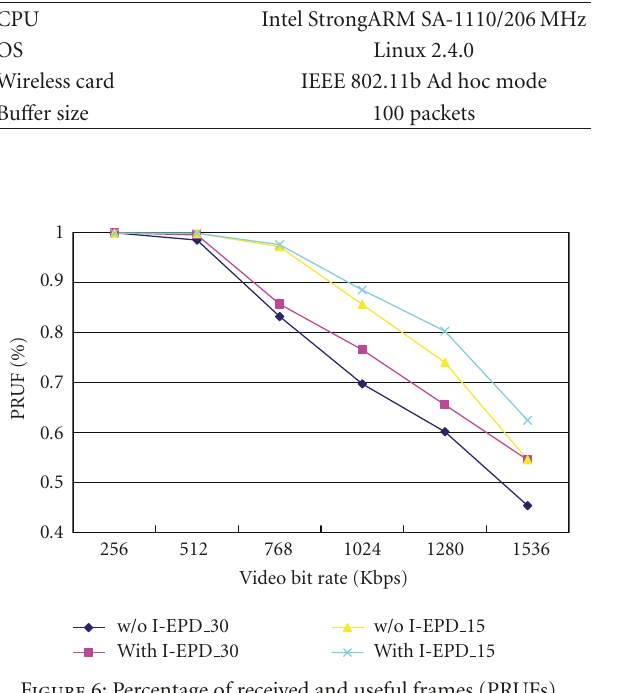
Figure 7: Percentage of video packets dropped at IN